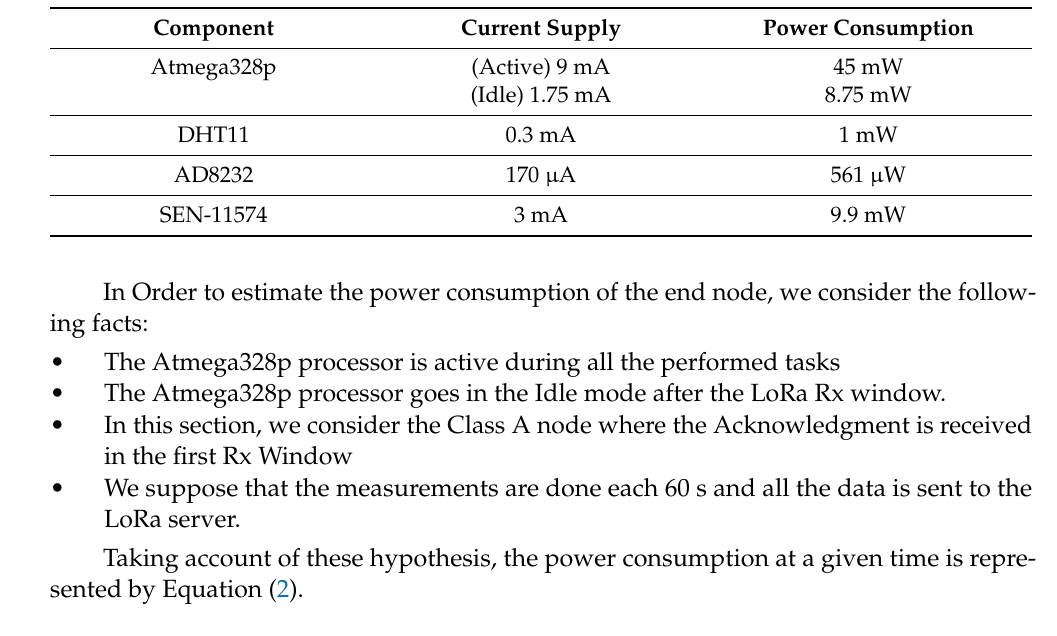
Table 7. Atmega328p Processor and sensors Power